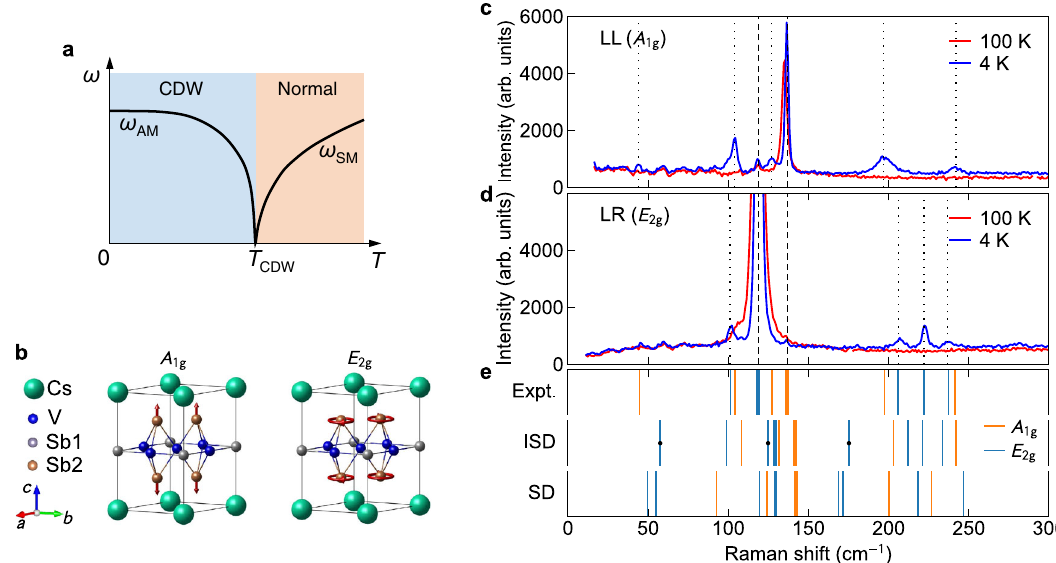
Fig. 1 Raman-active phonon modes in CsV 3 Sb 5 . a Schematic illustration of the relation between the soft mode and amplitude mode in typical CDW materials, showing the latter emerges after the former freezes below T CDW . ω AM : amplitude mode frequency. ω SM : soft mode frequency. b Crystal structure of CsV 3 Sb 5 . Sb sites with different Wyckoff positions are labeled as Sb1 and Sb2. The arrows illustrate the vibration patterns of the main lattice A 1g and E 2g modes. The E 2g mode is doubly degenerate, and only one form is shown. c , d Raman spectra measured on the ab -plane at 100 K and 4 K in the LL and LR polarization con fi gurations. The dashed lines denote the main lattice phonons, and the dotted lines indicate the CDW-induced modes. e Comparison of the measured (Expt.) and the calculated Raman mode frequencies for the inverse Star of David (ISD) and Star of David (SD) lattice distortions. The thick lines denote the main lattice phonons. The dots indicate modes undetected in our